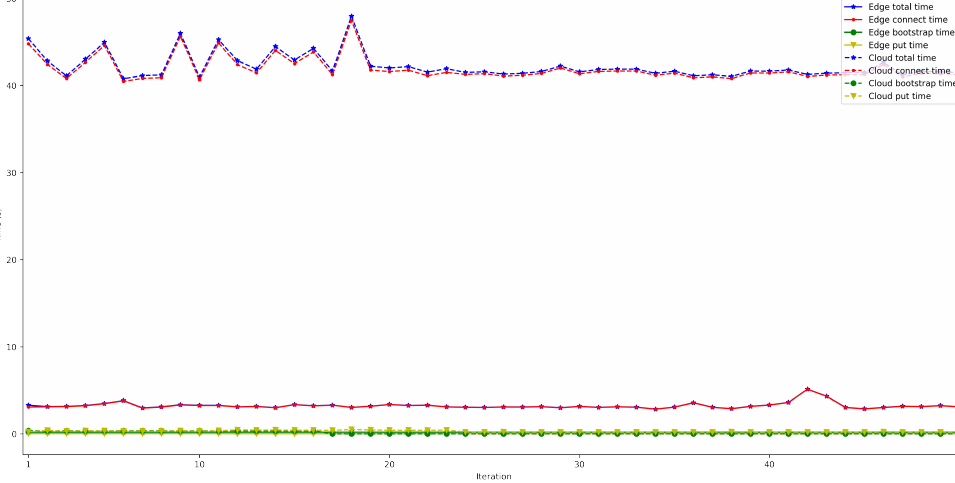
Figure 12. Latency when running the bootstrap node in the edge/cloud for 600 connected peers. Latency differences between running the bootstrap node on the Edge and on the Cloud can be easily spotted through Figure 13, which represents together the mean total times (already depicted in Figures 8–12) against the number of connected peers. As can be observed, the mean increases with the number of connected peers, being it clearly higher when executing the bootstrap node on the Cloud.